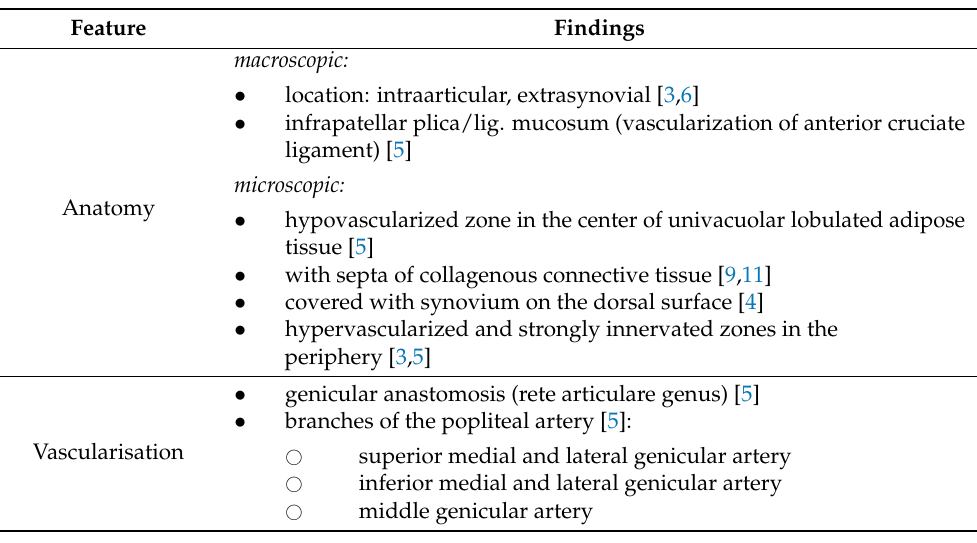
Table 1. Summary of the anatomical and functional features of the IFP